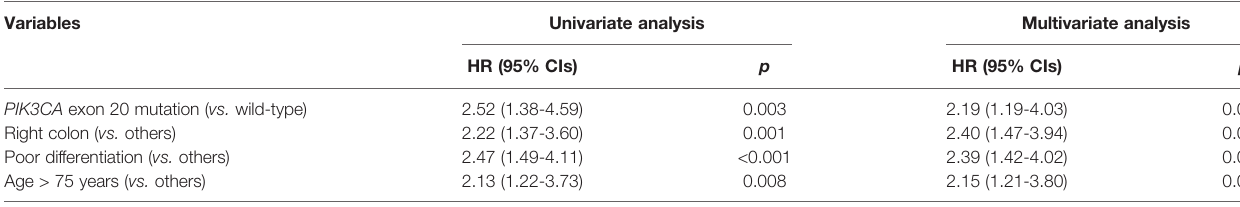
TABLE 3 | Cox regression model associations between clinicopathologic characteristics and mortality in stage IV CRC patients.